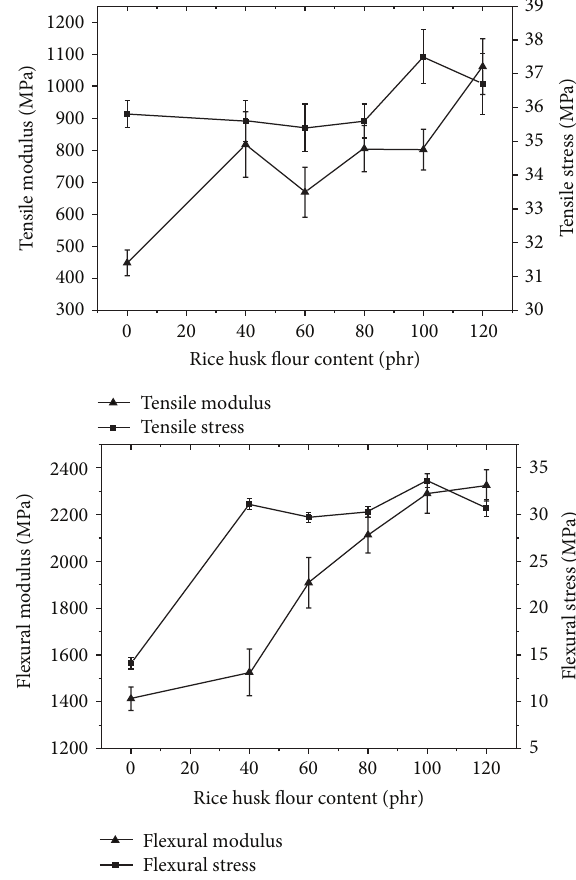
Figure 4: Effect of PP-g-MA content on tensile and flexural strength of PP/RHF (100/100) composites.